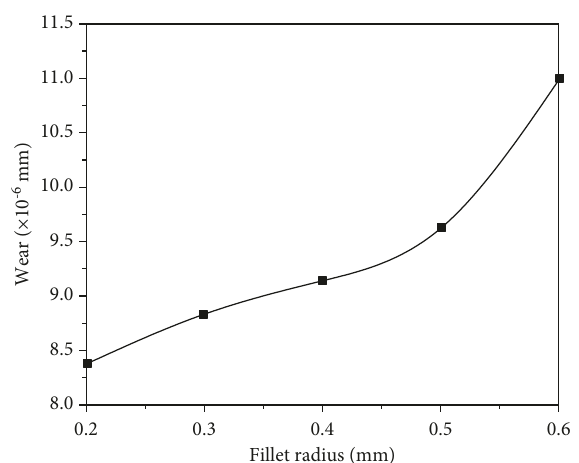
Figure 7: Effect of die fillet radius on die wear.